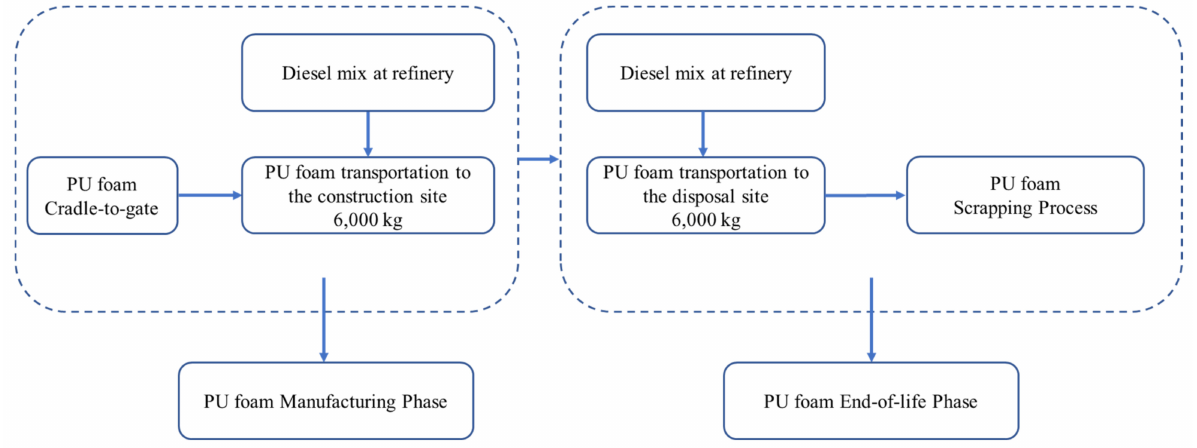
Figure 9. Flow diagram of PU foam.